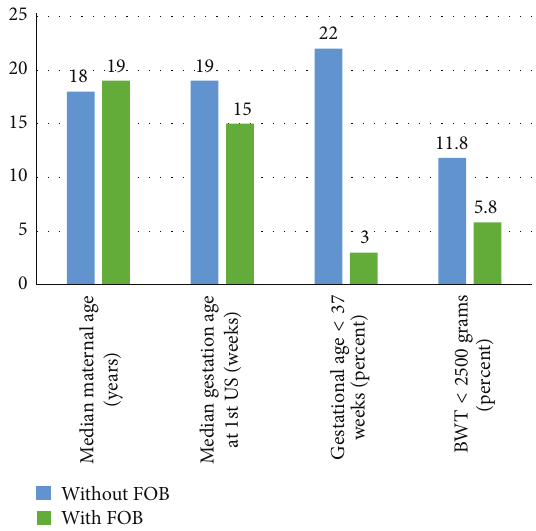
Figure 2: Association of the presence of father of baby with prenatal and pregnancy